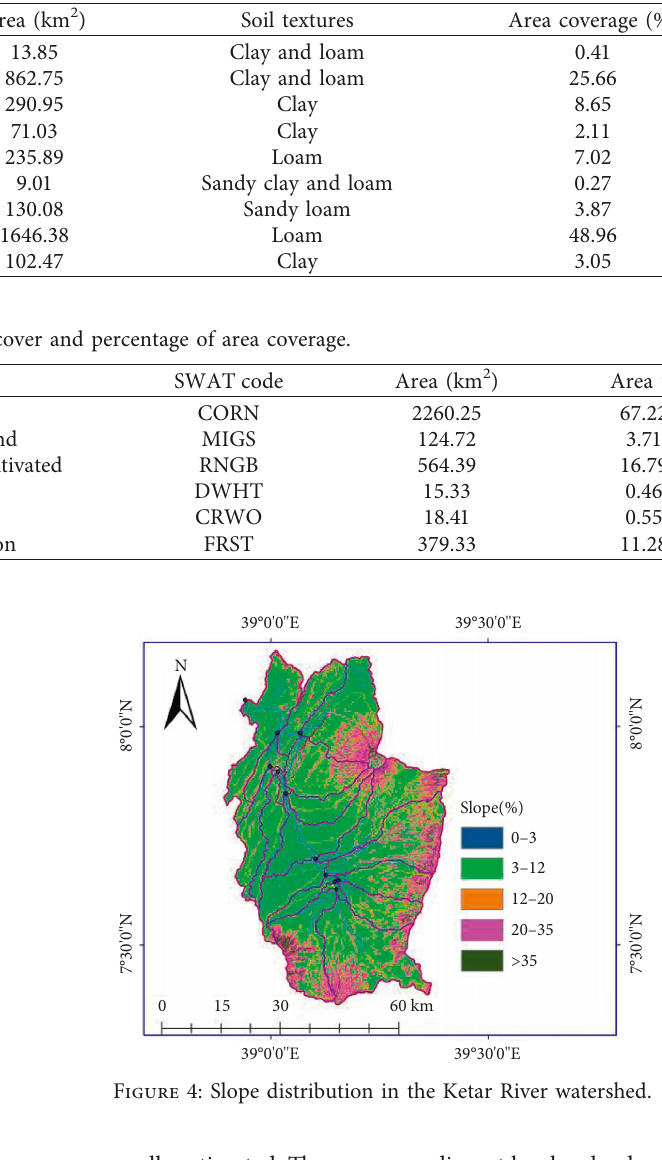
Table 2: Dominant soil types in the watershed with their corresponding percentage of coverage.